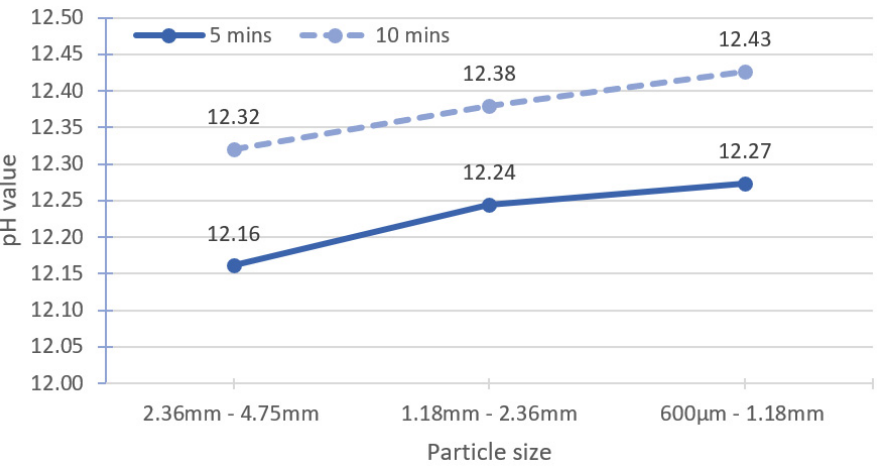
Figure 7. Effect of changing leaching time to 10 min for large particle size.